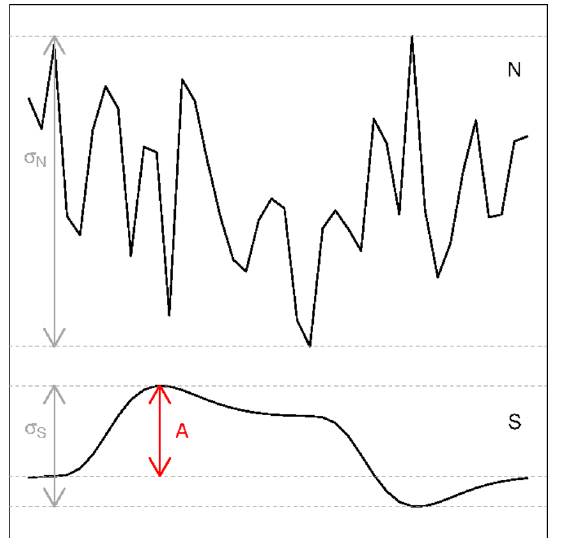
Figure 2. Illustration of the notation in the SNR and CNR definitions: S is the activation signal, N the noise signal, A defines the amplitude of the activation signal, and s S and s N indicate the standard deviation of the activation signal and noise signal respectively.